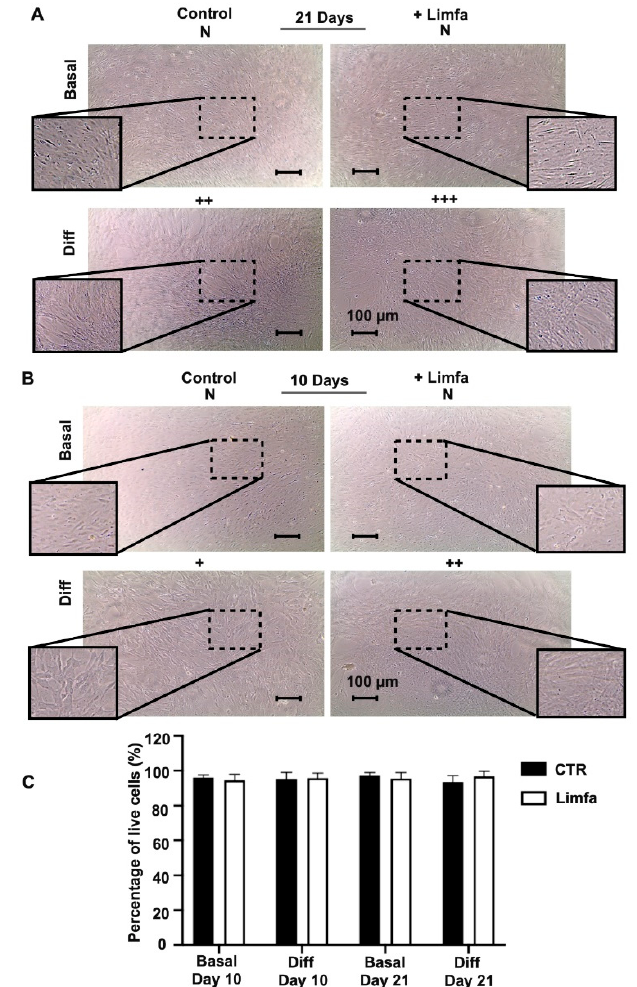
Figure 1. Morphological examination of ADSCs 2D cultures after 10 and 21 days of culture. Cells have been examined under different conditions. Basal, which corresponds to cells cultured in basal adipose stem cells medium; Basal + Limfa, which corresponds to cells cultured in basal adipose stem cells medium and treated with Limfa ® Therapy; Diff, which corresponds to cells cultured in chondrogenic differentiation medium; Diff + Limfa, which corresponds to cells cultured in chondrogenic differentiation medium and treatment with Limfa ® Therapy. Scoring system: +, weak differentiation; ++, moderate differentiation; +++, strong differentiation. ( A ) cell images after 21 days of Limfa treatment ( B ) cell images after 10 days of Limfa treatment ( C ) Cytotoxicity assay performed after 10 and 21 days of treatment. The scale bar corresponds to 100 µ